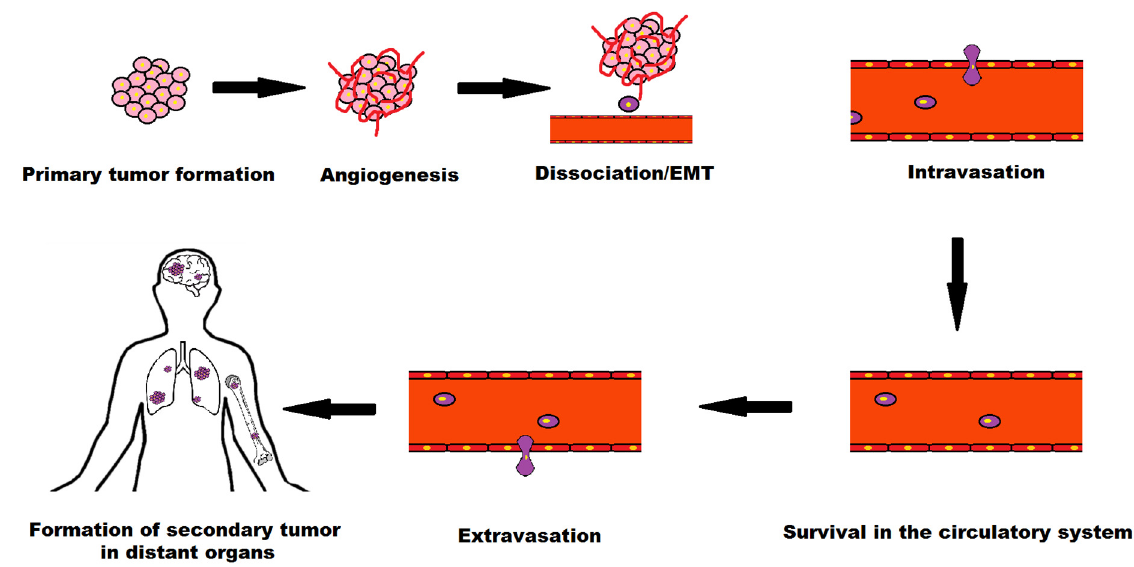
Figure 6. Schematic showing the process of cancer metastasis. The key stages of metastatic process are (i) detachment of a tumor cell from the primary tumor site, (ii) invasion of basement membrane by extension or penetration through neighboring tissues, (iii) intravasation into the vascular or lymph vessels of the nearby region, (iv) survival as circulatory tumor cells (CTCs), (v) extravasation from blood vessels to secondary tissue and (vi) infiltration at subsequent tumor site [29]. Here, intravasation and extravasation are the entry and exit of tumor cells from the circulatory or lymphatic system. Circulatory tumor cells (CTCs) refer to the cells that are shed from the primary tumor site to the circulatory or lymphatic system and carried around the body in blood circulation. There are very few to be found in blood, around 1–10 CTCs per mL of whole blood